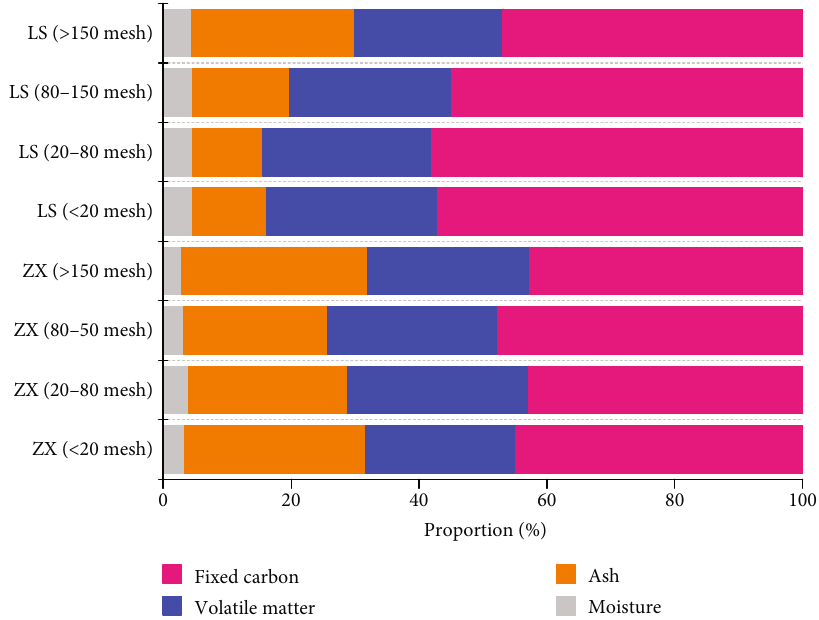
Figure 7: Proximate analysis results of drilling cuttings and bailing coal fi